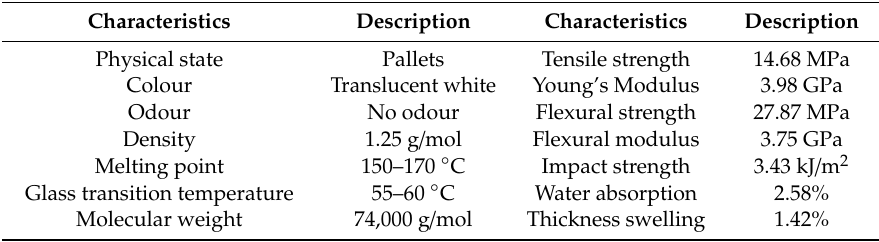
Table 1. Properties of polylactic acid (PLA) biopolymer [19].